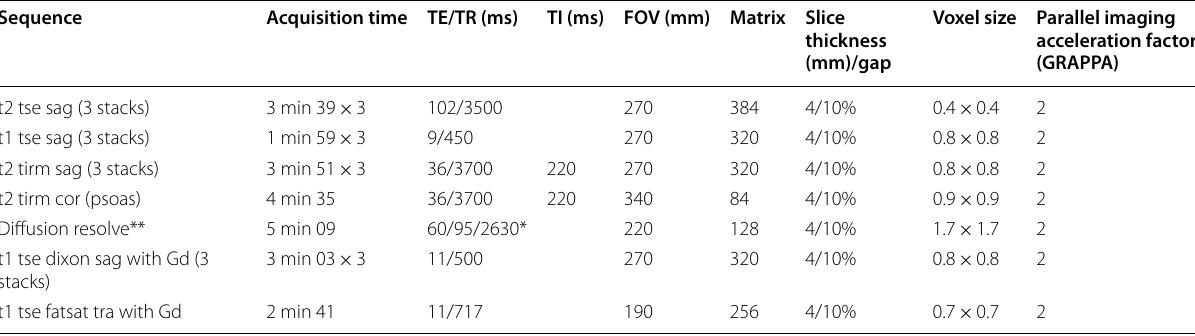
TSE, TurboSpinEcho; Sag, sagittal; Cor, coronal; Fatsat, fat saturation; Tra, transverse; Gd, gadolinium; min, minute; mm, millimetre; ms, millisecond; TE, echo time; TR, repetition time; TI, inversion time *Resolve sequence has 2 TE **Sag 4b values (b0, 300, 600, 800)